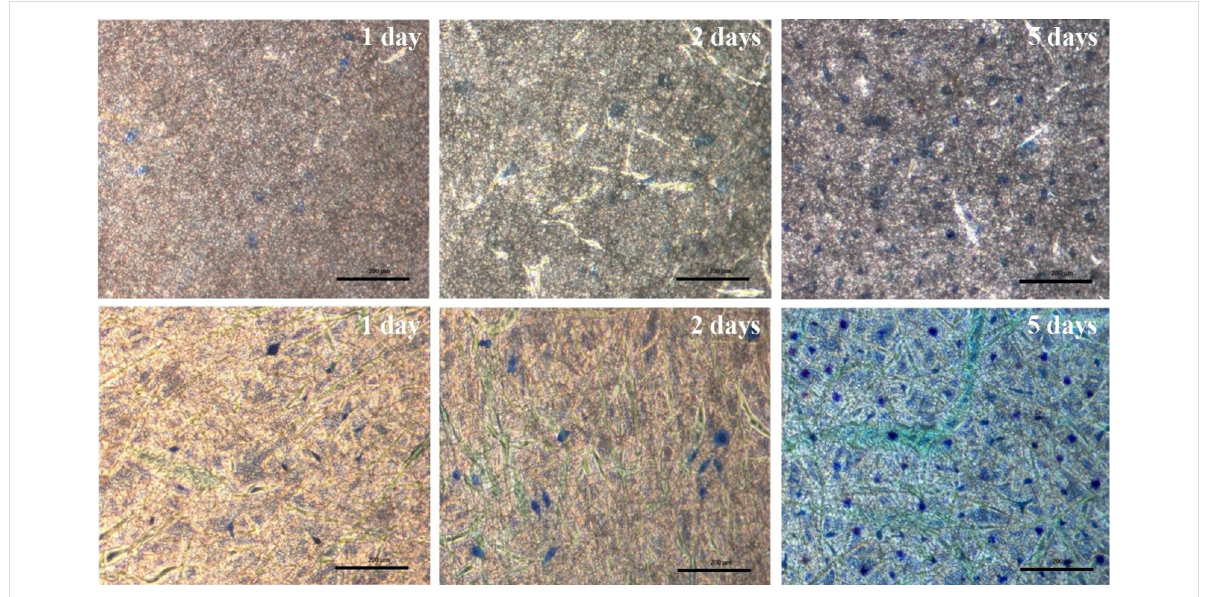
Figure 9: Optical microscopy images of the cell morphology on the examined scaffolds. The three pictures in the upper row display the CA scaffolds, while the three pictures in the lower row indicate the CA:dexam scaffolds after the 1st, 2nd and 5th day, respectively (scale bars: 200 μ m).